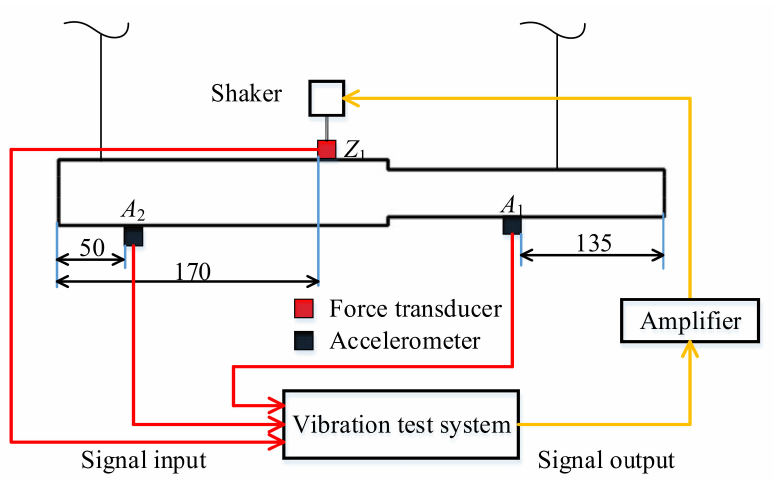
Figure 2. Details of the test setup (source elaborated by